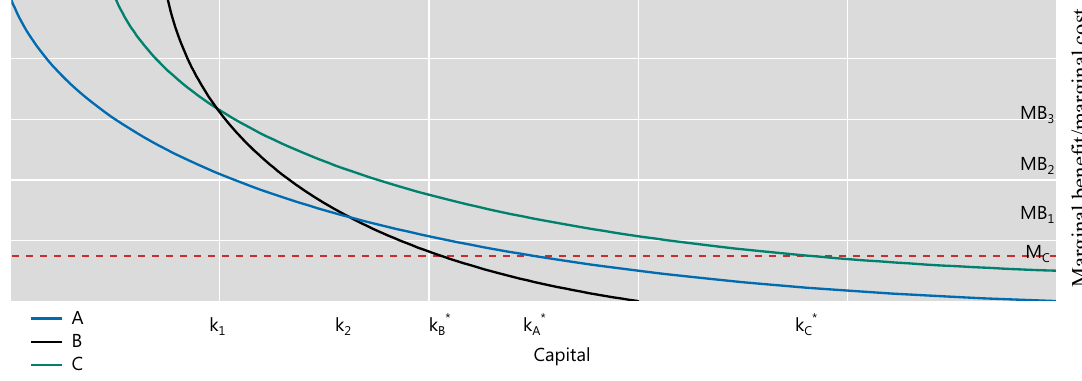
Figure A3. Marginal costs, marginal benefits and optimal levels of capital.